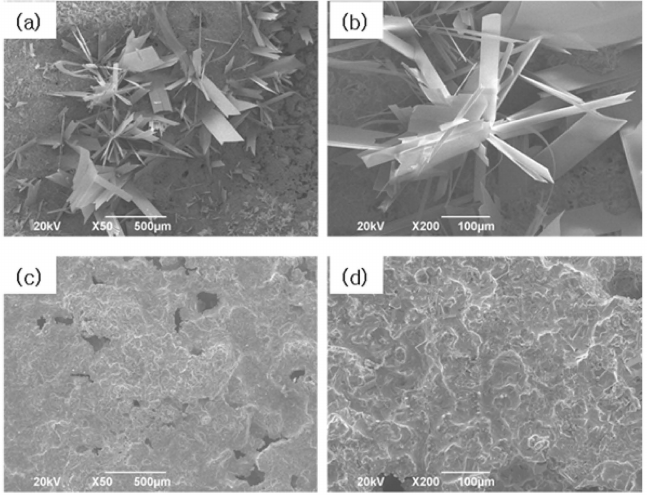
Figure 3. Surface morphologies of FeCrAl plasma thermal spray-coated TZM alloys: ( a , b ) as-sprayed; ( c , d ) after the laser treatment.